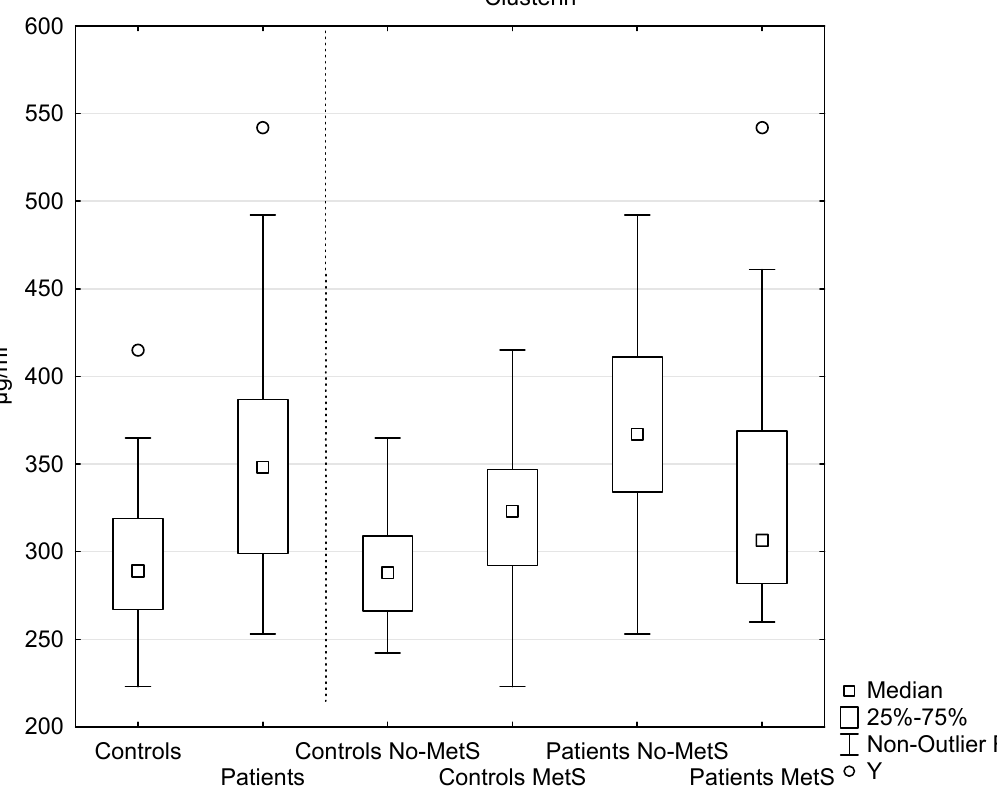
Figure 2. The levels of serum clusterin in the controls and in the patients, as well as the levels of serum clusterin in the subgroups of the controls and the patients with and without metabolic syndrome. Y indicates an outlier. An outlier is any data point value > 75th percentile + 1.5 * (75th percentile–25th percentile) or any data point < 25th percentile–1.5 * (75th percentile–25th percentile). Controls vs. patients, p < 0.001; MetS patients vs. no-MetS, p < 0.05; no-MetS patients vs. no-MetS control, p < 0.001.